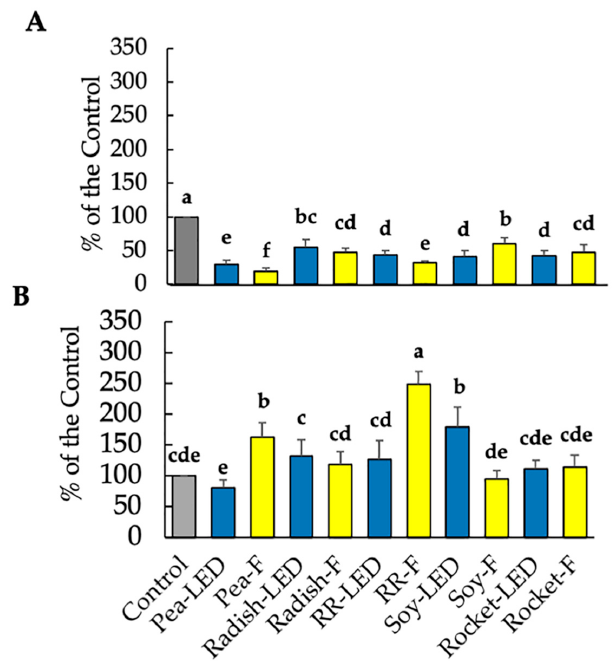
Figure 8. Cell vitality (MTT assay) on 2D A673 ( A ) and 3D A673 ( B ) exposed for 24 h to 20 µ L green pea, radish, Red Rambo (RR), soybean (soy), and rocket microgreen extracts, cultivated under LED and fluorescent (F) lighting. Values are the mean ± SD of six replicates ( n = 6). The different lowercase letters (a–e) represent significant differences between the microgreen species under different lighting ( p < 0.05) for each treatment, as determined from a one-way